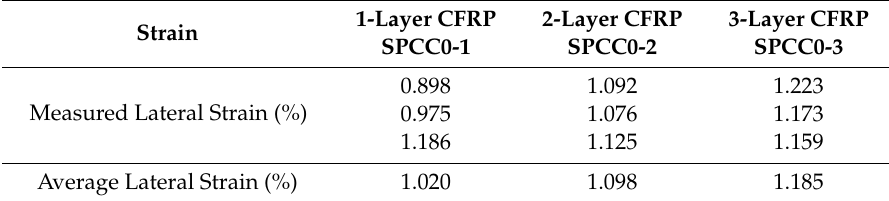
Table 12. The measured lateral strains at the maximum compressive strength of